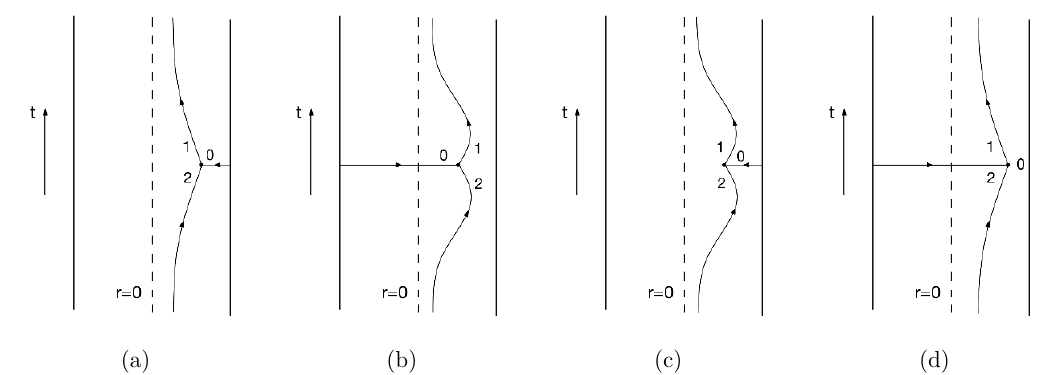
Figure 3 . Geodesics behaviour depending on the sign of the intermediate dimension. It is shown in the text that only the options ( a ) and ( d ) are realized, when (cid:15) p > 0 and (cid:15) p < 0 respectively. Arrows show the orientation of geodesics, chosen in the